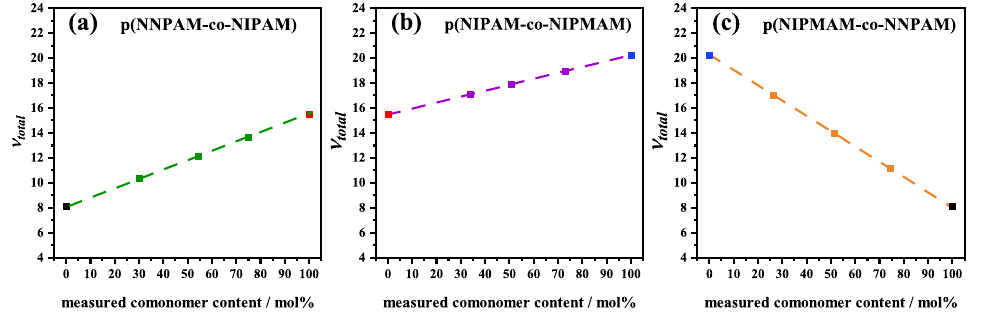
Figure 5. Total number of water molecules leaving the gel per segment at the volume phase tran- sition ν total vs. measured comonomer content of homopolymer systems poly(NNPAM) (black), poly(NIPAM) (red) and poly(NIPMAM) (blue) and copolymer systems poly(NNPAM-co-NIPAM) (green) ( a ), poly(NIPAM-co-NIPMAM) (purple) ( b ) and poly(NIPMAM-co-NNPAM) (orange) ( c ). ν total was calculated with Equation (13). ν total follows a linear trend between the ν values of the homopolymer systems. The dashed lines are guides to the